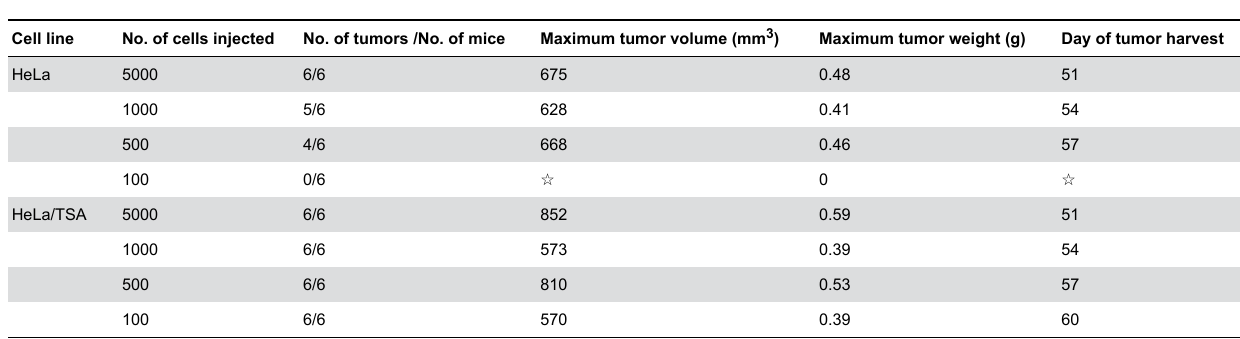
Table 1. Evaluation of tumorigenicity of HeLa and HeLa/TSA cells.